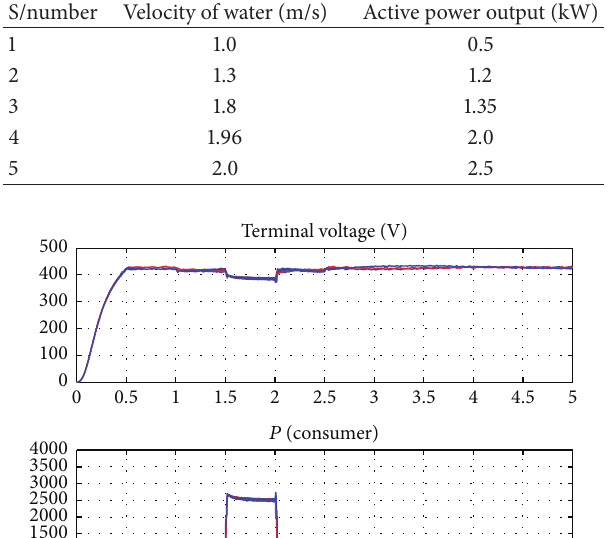
Figure 8: System frequencies.